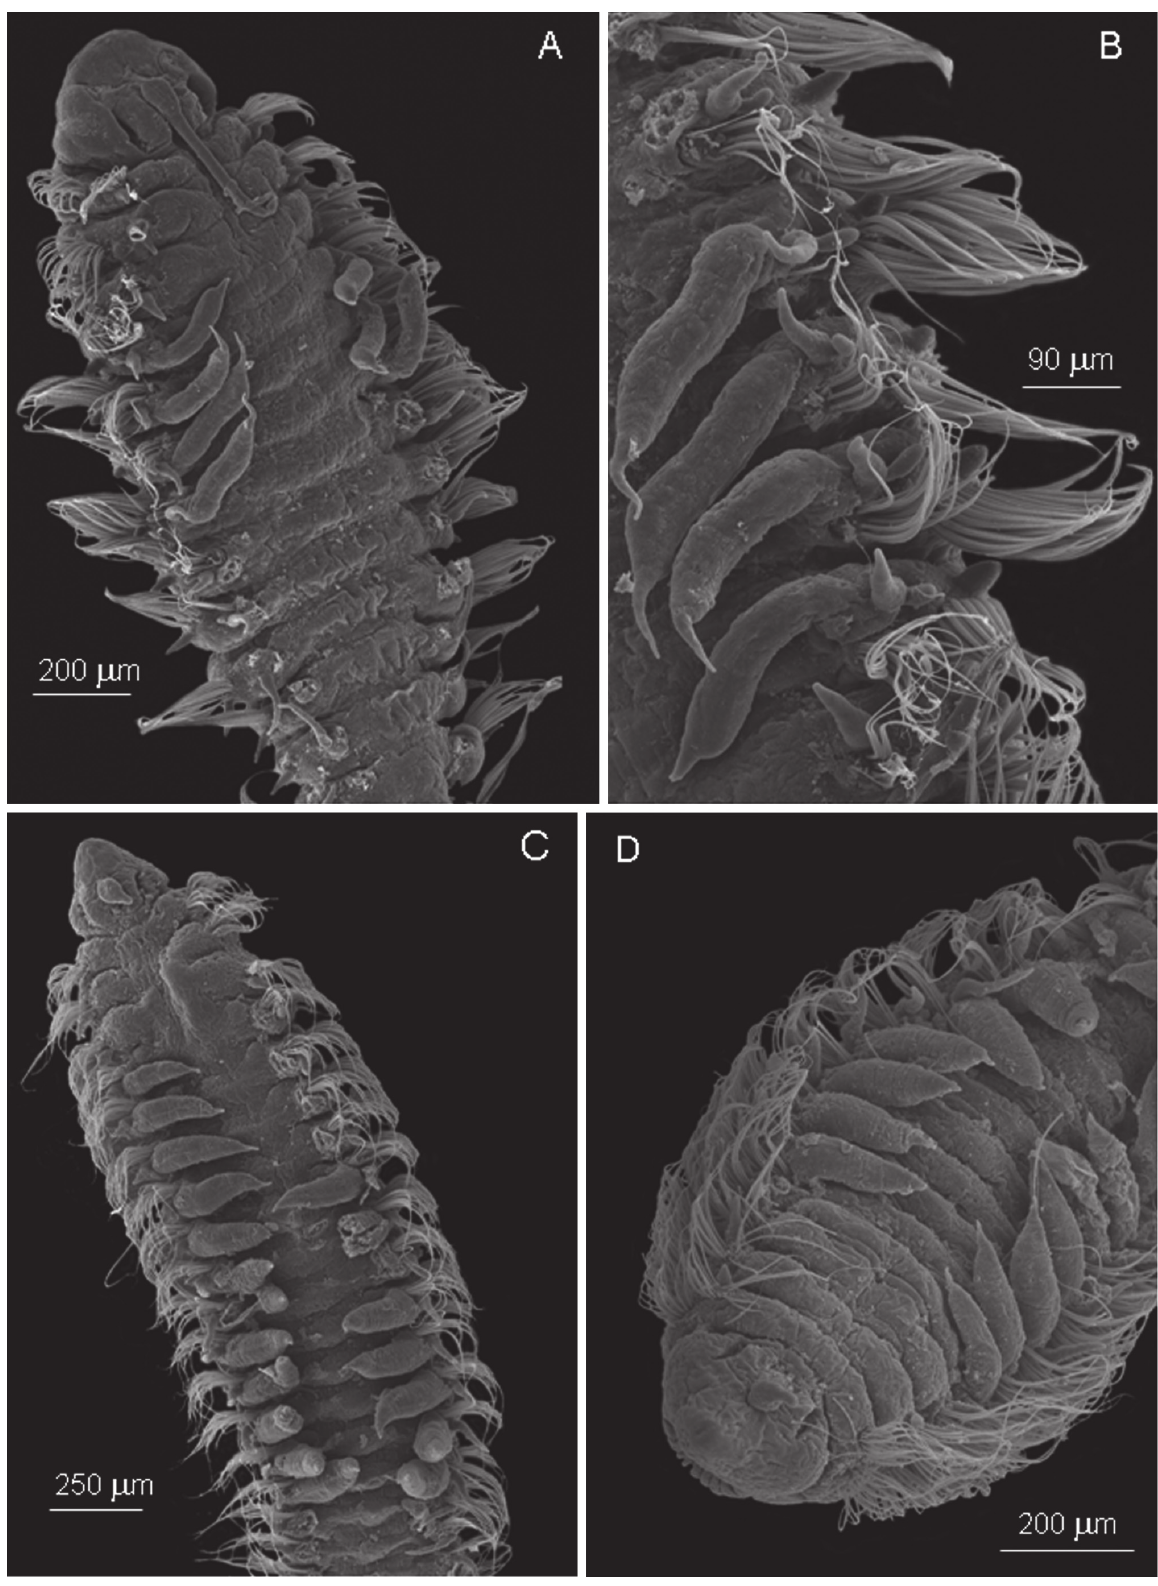
Fig . 19. – Aricidea ( Allia ) antennata : A, anterior region, dorsal view; b, branchial region, chaetigers 5-8, left side of animal. Aricidea ( Allia ) mirunekoa n. sp.: c-D, anterior region, dorsal view. Scale bar: A 200 µ m; b 90 µ m; c 250 µ m; D 200 µ